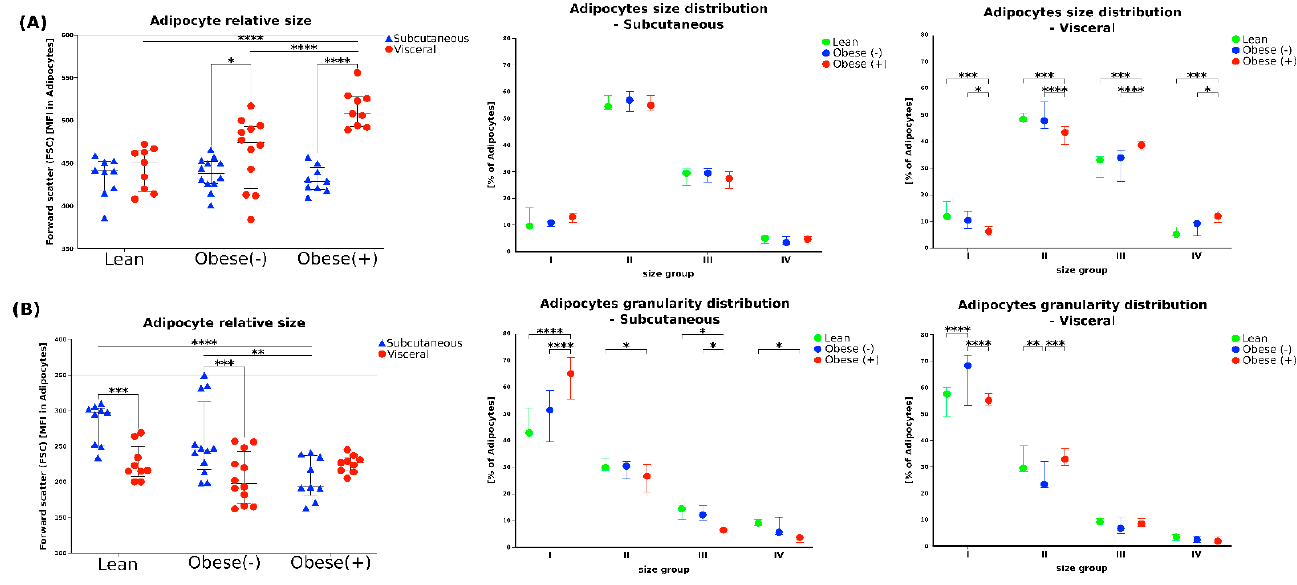
Figure 5. The size and the granularity of adipocytes differentiated from subADMSCs and visADMSCs of lean and morbidly obese women. The cells were characterized based on the forward scatter (FSC, relative to adipocytes size) and side scatter (SSC, relative to adipocytes internal structure) during flow cytometry analysis. ( A ) Adipocytes relative size and size distribution. ( B ) Adipocytes relative granularity and granularity distribution. Numbers indicate ranges used to classify the cells to different groups based on the cell size (I: 0–275, II: 275–550, III: 550–825, IV: 825–1100) or granularity (I: 0–250, II: 250–500, III: 500–750, IV: 750–1100). *— p < 0.05; **— p < 0.01; ***— p < 0.001; ****— p < 0.0001. The inner horizontal line represents the median. Whiskers: 25–75 percentile. n = 3